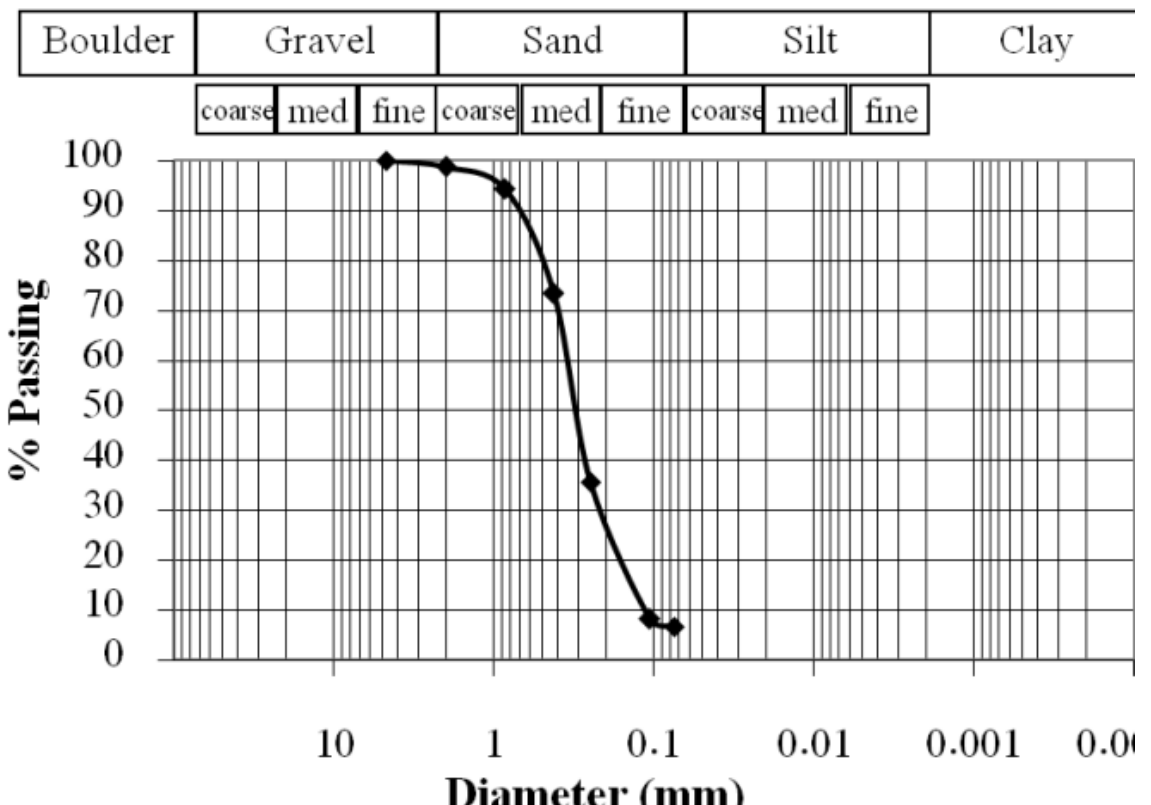
Figure 18. The sieve analysis of specimen 12 at 90.5E km at Sarapum